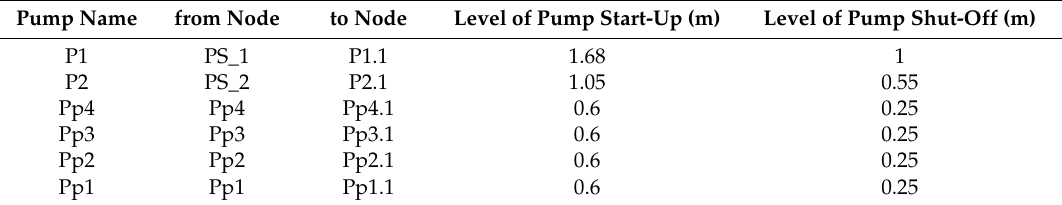
Table A4. Technical parameters of the